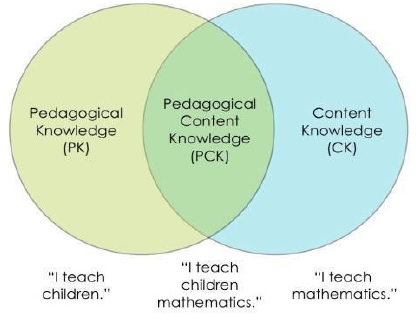
Figure 1. Shulmans’ [12] domain of pedagogical content knowledge.